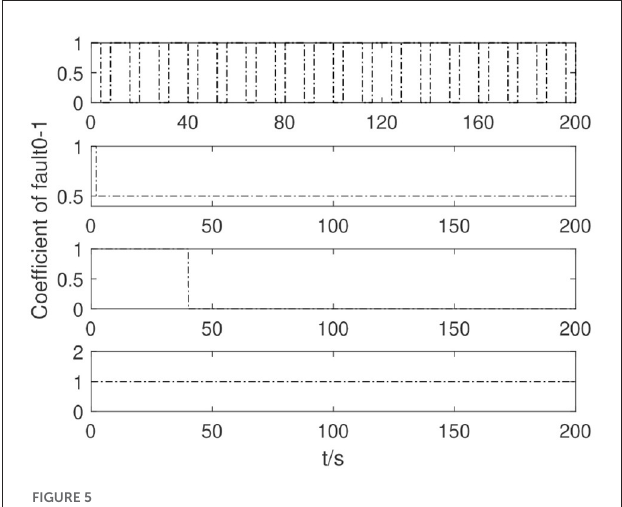
Trajectory tracking curve.